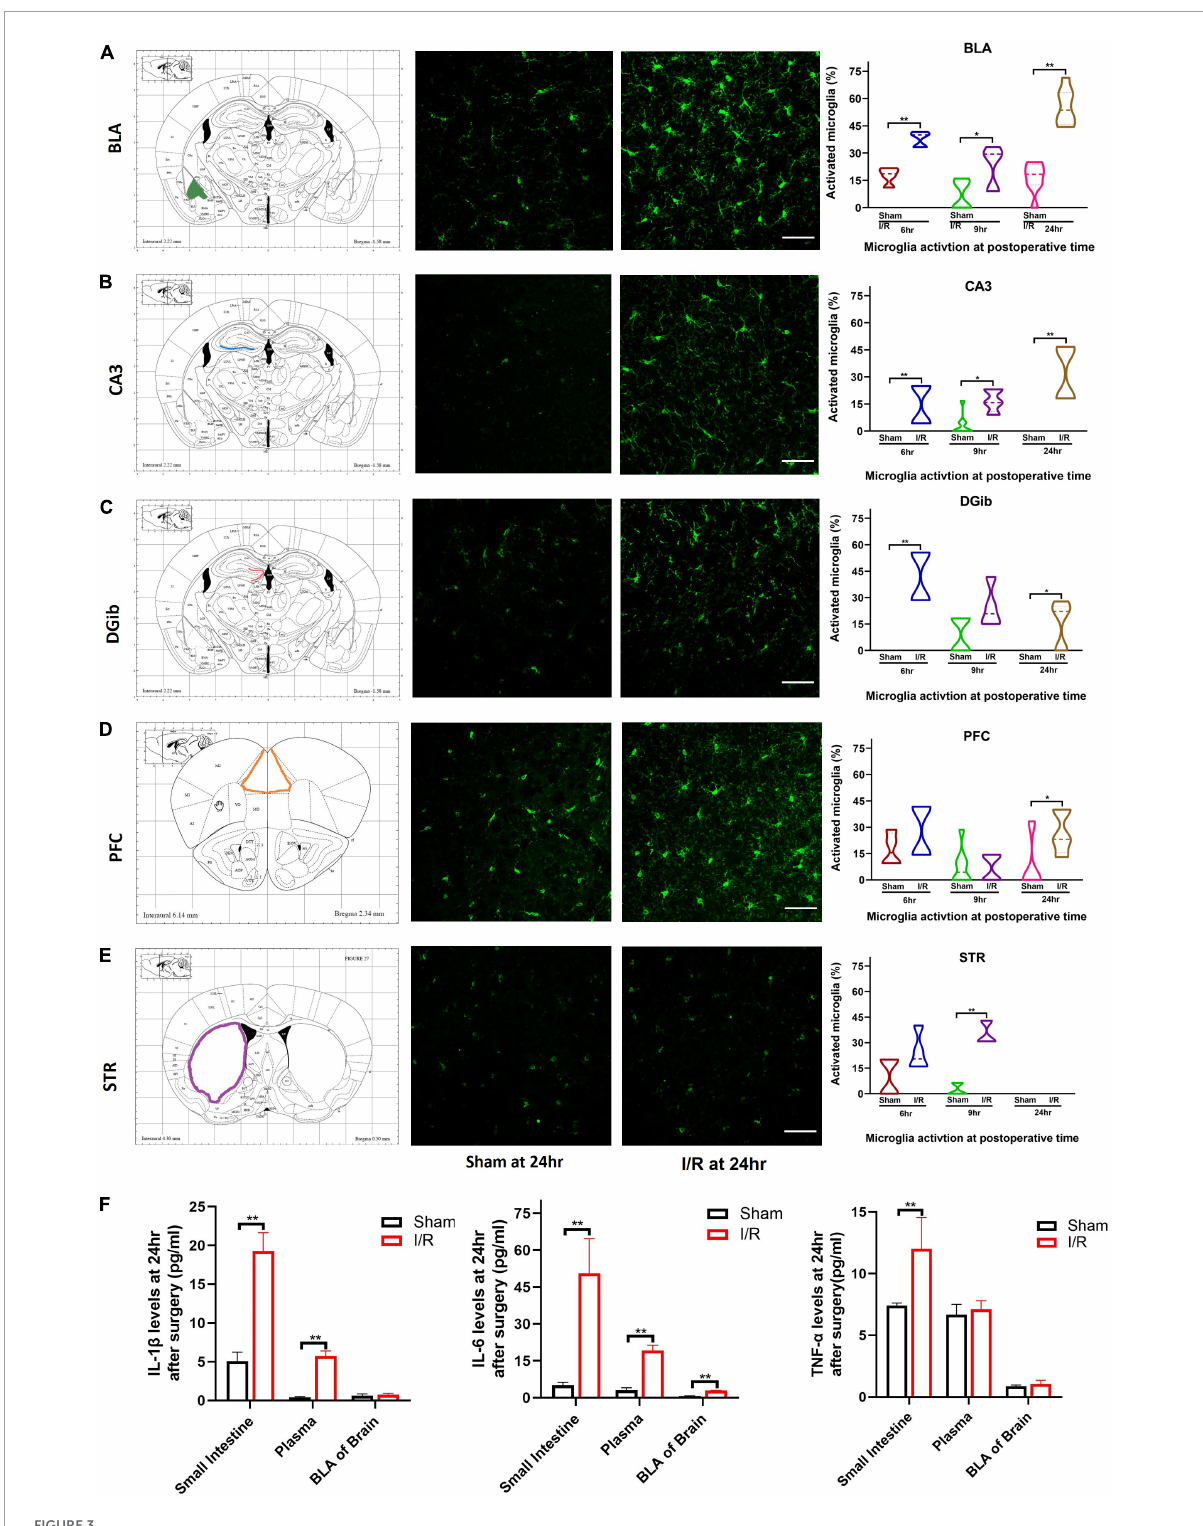
FIGURE3 Microglia reactivation in different brain regions and levels of proinflammatory cytokines at 24 h after surgery. (A) BLA. (B) CA3. (C) DGib. (D) PFC. (E) STR. (F) Levels of IL-1 β , IL-6, TNF- α in intestine, plasma, and BLA. The percentage data were expressed as median (IQR). N = 8 per group, * P < 0.05, ** P < 0.01. I/R, ischemia and reperfusion; hr, hours; BLA, basolateral amygdala; CA3, Cornu Ammonis; DGib, dentate gyrus inner blade; PFC, medial prefrontal cortex; STR,